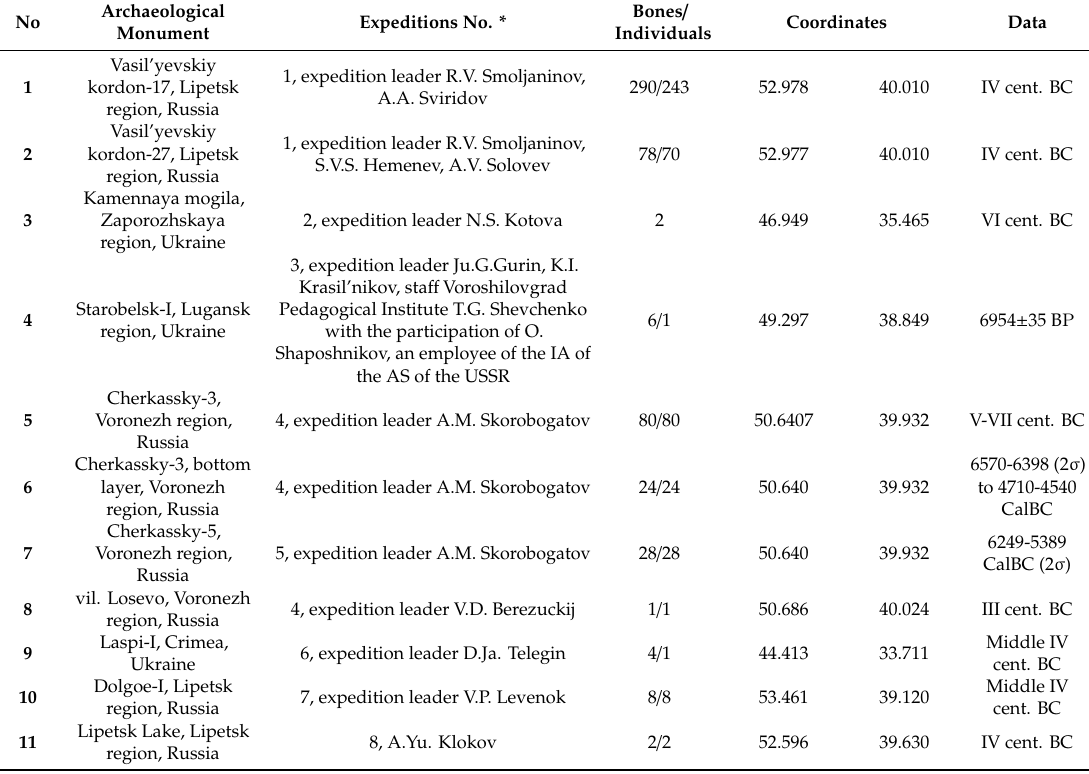
Table 1. Data on the found subfossil records of E. orbicularis